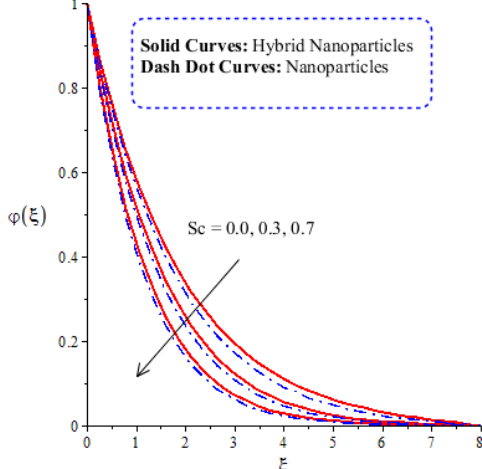
Figure 14. Comparative analysis of concentration in hybrid nanoparticles and nanoparticles with changes in 𝑆𝑐.